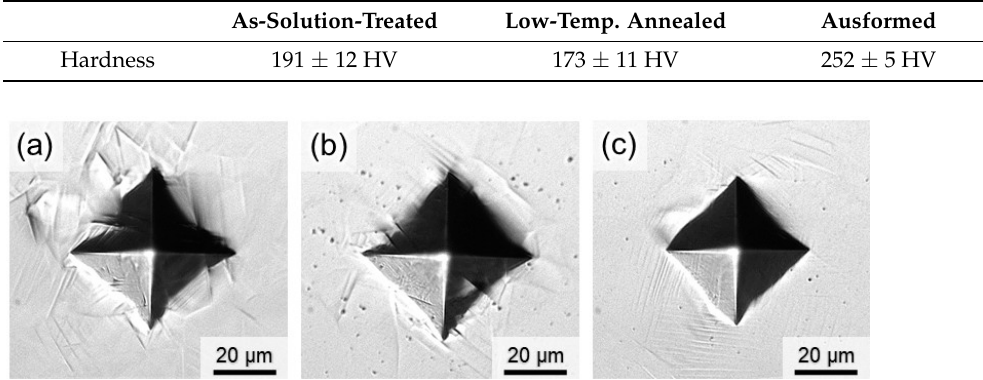
Table 2. Vickers hardness test results and their standard deviations.